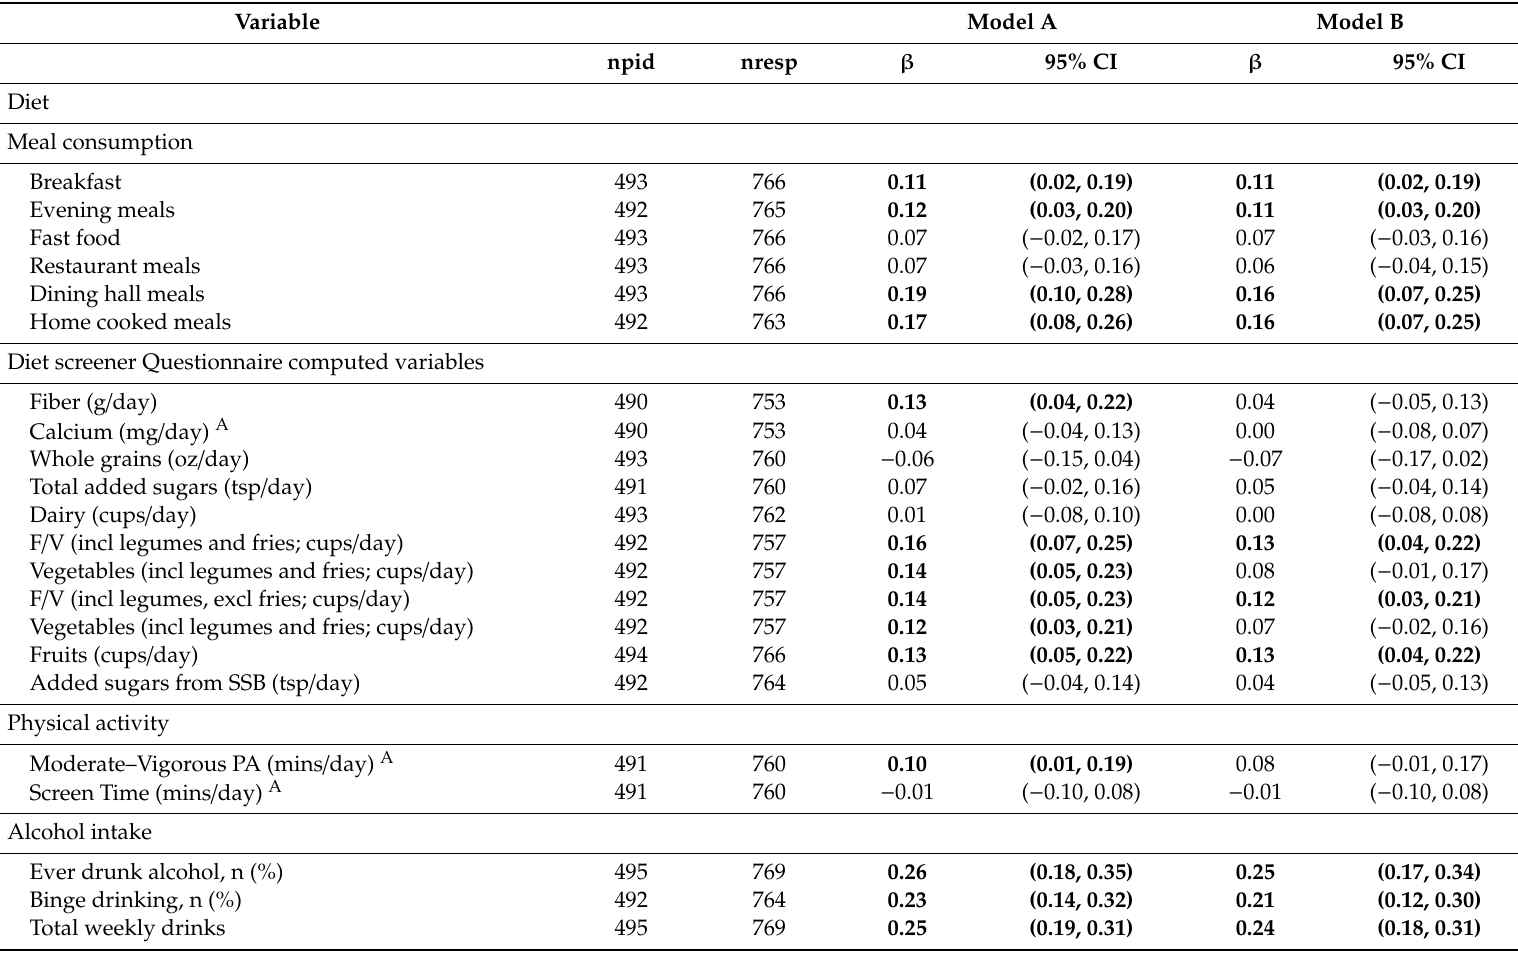
Table 3. Results of the cross-sectional linear mixed e ff ect model examining the similarity between students’ and their friends’ weight-related behavioral survey responses.